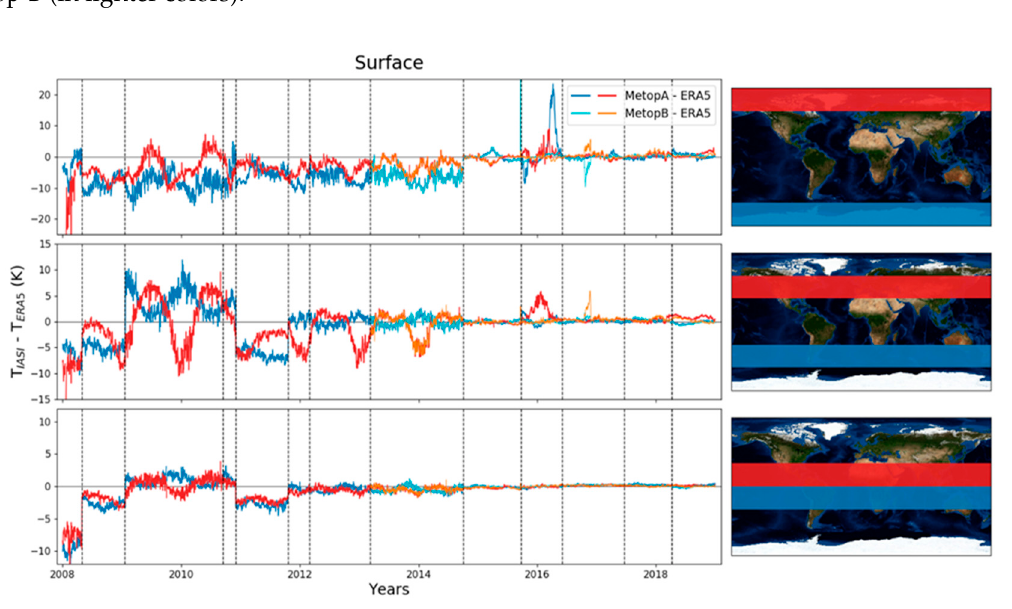
Figure 4. Differences between IASI-A and ERA5 (in dark colors), and IASI-B and ERA5 (in lighter colors) for surface temperature at the poles, mid latitudes, and equator. Differences in the Northern Hemisphere are plotted in red/orange and differences in the Southern Hemisphere are plotted in blue. The vertical dashed lines correspond to L2 updates. Note that the y-axis limits for each latitude band are different.